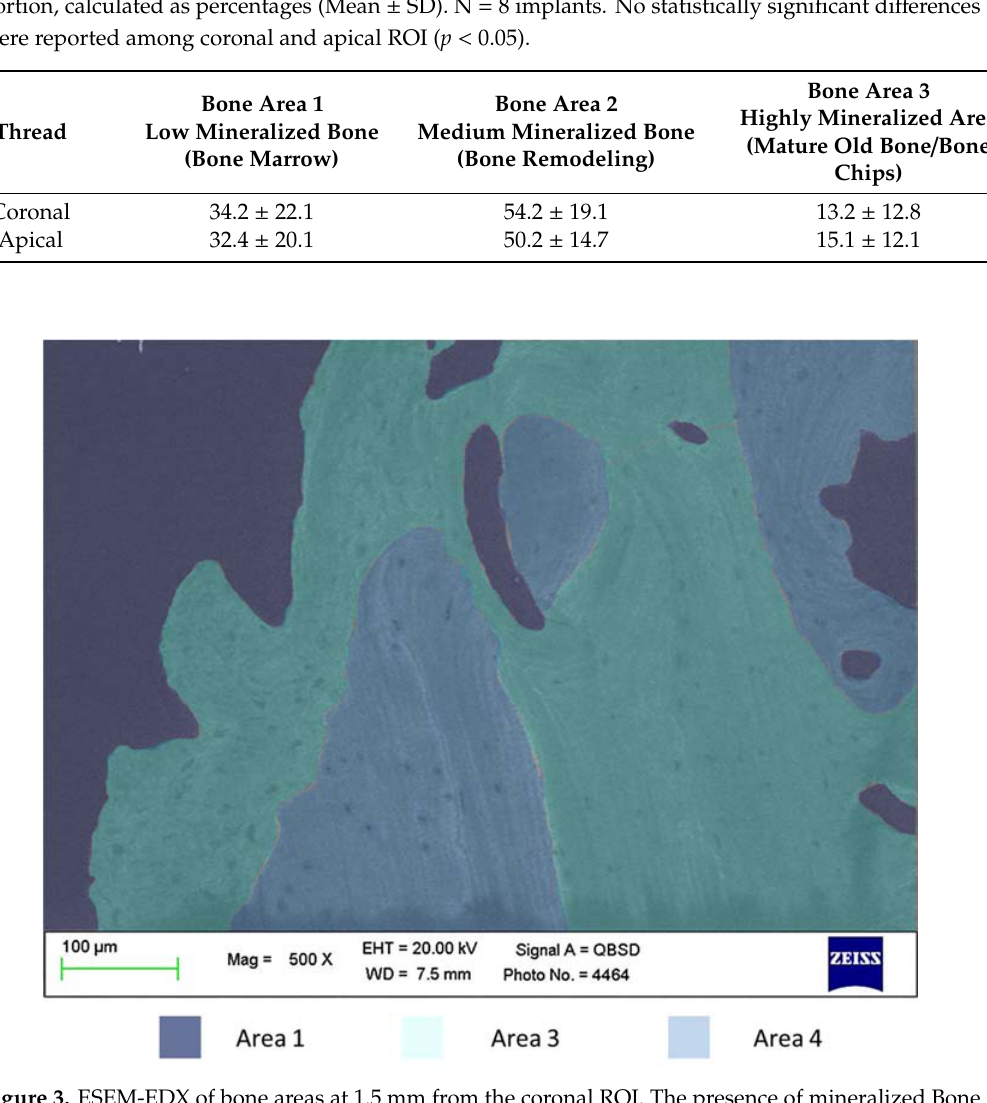
Figure 3. ESEM-EDX of bone areas at 1.5 mm from the coronal ROI. The presence of mineralized Bone Areas 3 and 4 was detected at this site. Bone Area 4 revealed higher Ca/N and P/N, but similar Ca/P ratios when compared to Area 3.